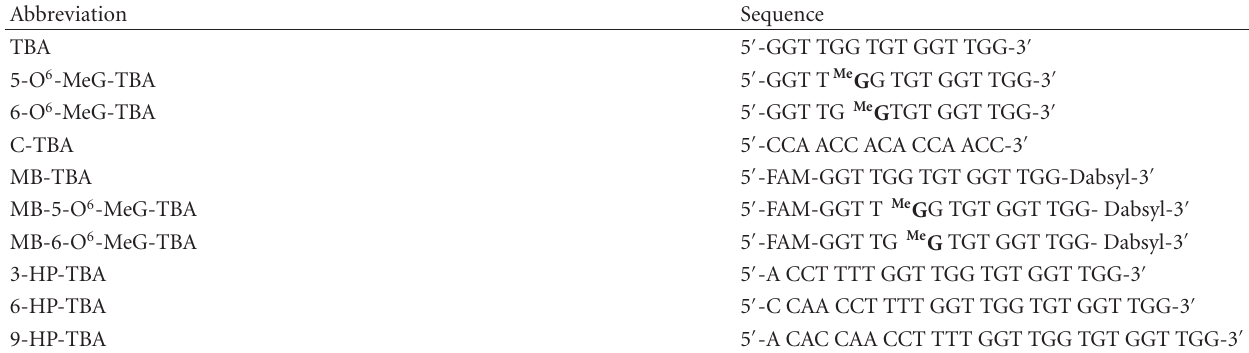
Table 1: Sequences of TBA oligonucleotide derivatives used in the development of the hAGT fluorescence assay. Me G represents O 6 - methylguanine. MB represents the fluorophore group (FAM), labelled in the 5 (cid:2) end, and the quencher group (Dabsyl), labelled in the 3 (cid:2) end of the